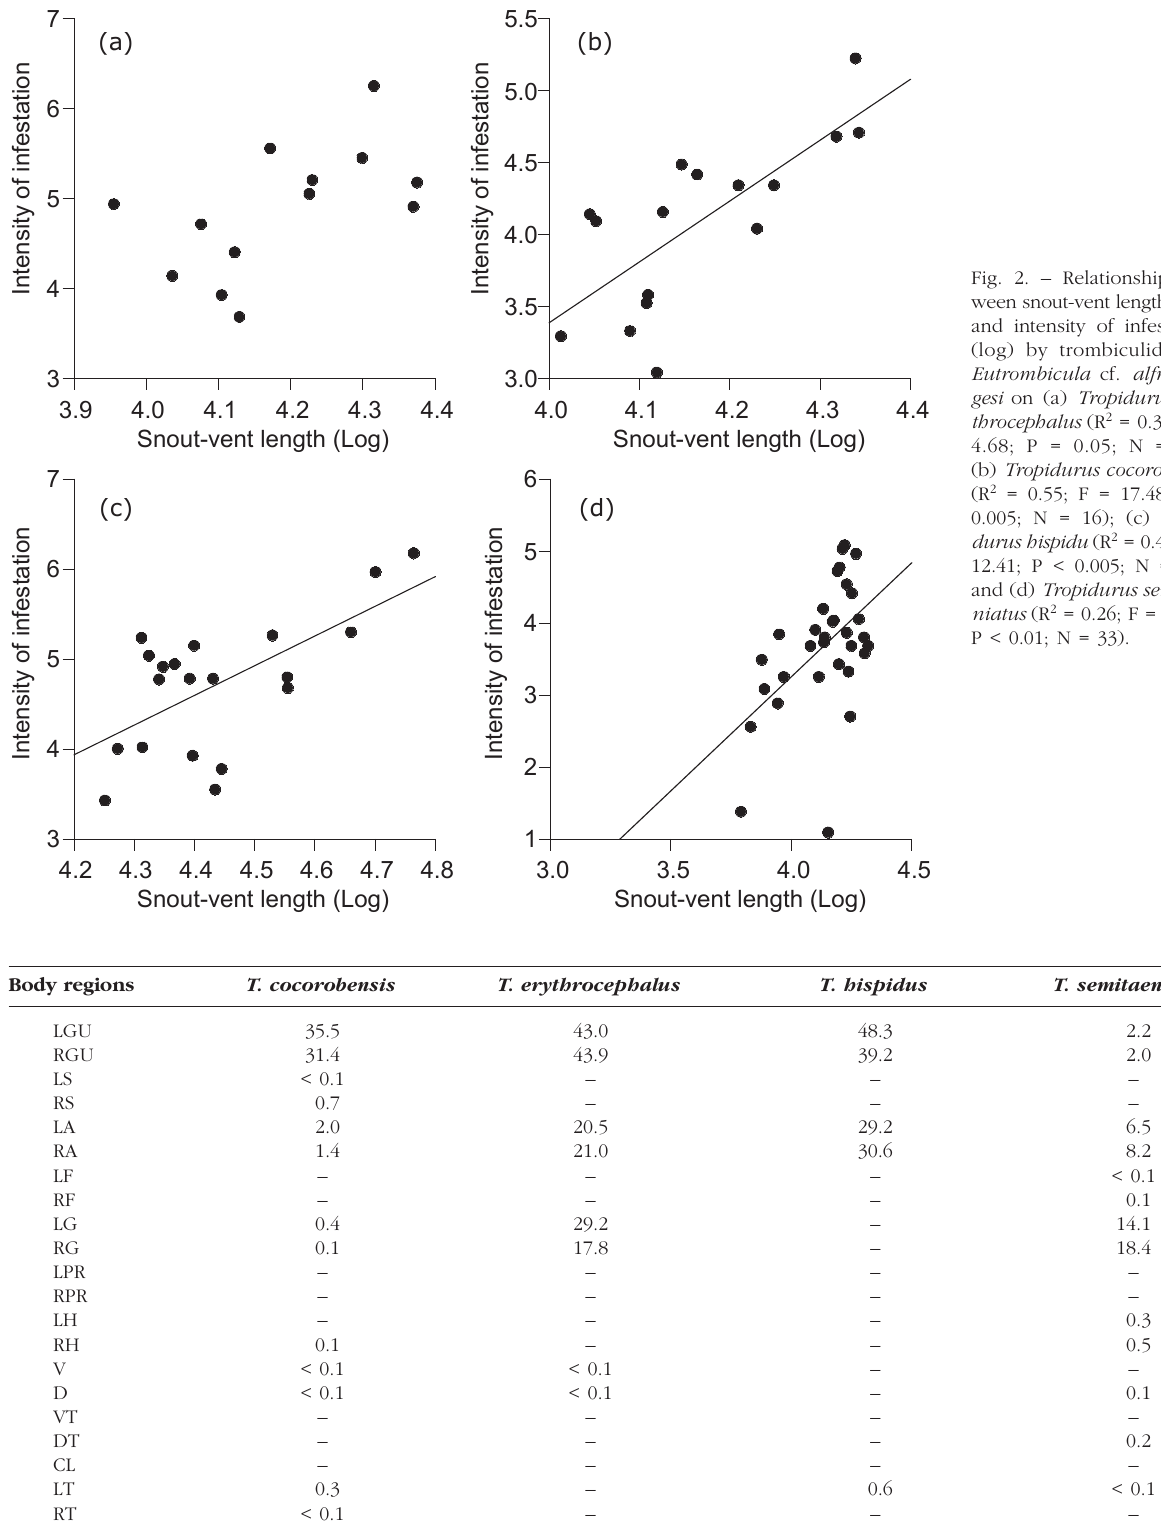
– – Table II. – Mean abundance of Eutrombicula aff. alfreddugesi per region of the host’s body for each of the four Tropidurus species at Morro do Chapéu, in northeastern Brazil. Codes for the lizards’ body regions are: left gular (LGU); right gular (RGU); left shoulder (LS); right shoulder (RS); left axilla (LA); right axilla (RA); left foreleg (LF); right foreleg (RF); left groin (LG); right groin (RG); left postfemoral region (LPR); right postfemoral region (RPR); left hindleg (LH); right hindleg (RH); venter (V); dorsum (D); ventral tail (VT); dorsal tail (DT); cloaca (CL); left tympanum (LT); right tympanum